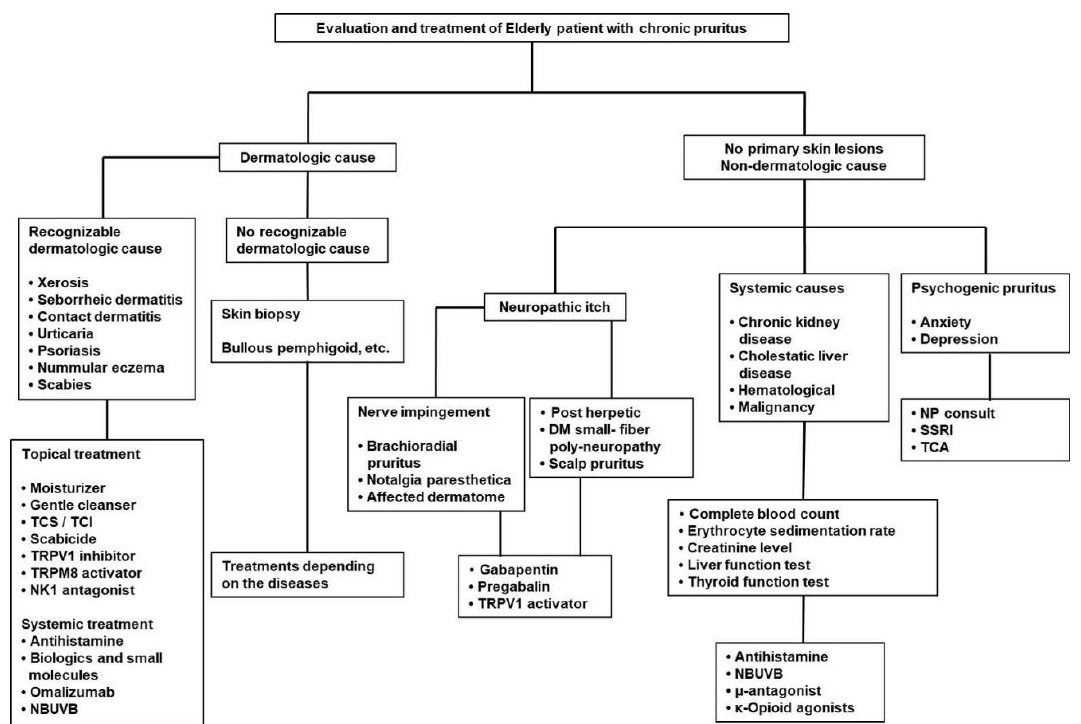
Figure 1. Suggested diagnostic work-up and the treatment for the chronic pruritus in elderly. TCS (topical corticosteroids), TCI (topical calcineurin inhibitor), TRPV (transient receptor potential vanilloid), TRPM (transient receptor potential melastatin), NK (neurokinin), NBUVB (narrowband ultraviolet B), DM (diabetes mellitus), NP (neuropsychology), SSRI (selective serotonin reuptake inhibitor), TCA (tricyclic antidepressant).